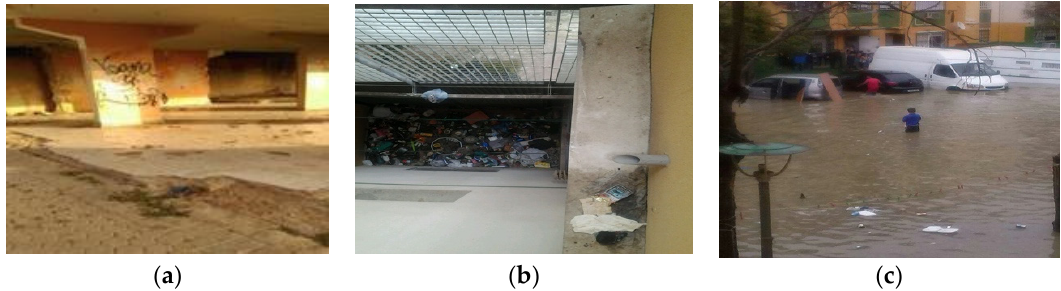
Figure 5. Unlivable housing conditions. ( a ) ”There was a rehabilitation plan, they took the people out for construction and it was left half done”. Despite local rehabilitation plans, “These buildings have been like this for ten years ... homeless people and drug addicts occupy the building ... when they are cold they build fireplaces and the building goes up in flames constantly”. ( b ) “There is a hole where a wash sink was that was torn out and now it is full of trash. Next door there are people who live with the trash and smell”. ( c ) This was a photograph a neighbor sent to the Whatsapp group after we finished the formal Photovoice sessions. After a day of rainfall in Sevilla, neighbors were unable to leave their homes because of the poor sewage system.